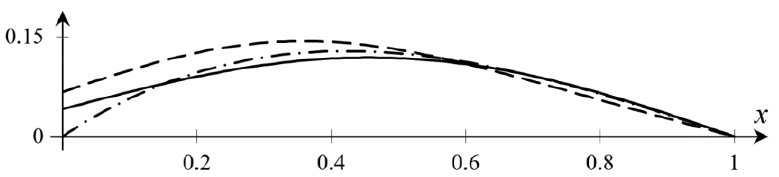
Figure 4. Graphs of 𝑄 1 (𝑥, 3) (solid line), 𝑄 2 (𝑥, 3) (dashed line) and 𝜑 1 (𝑥) (dash-dotted line). Graphical representations of the functions 𝑄 1 (𝑥, 6) and 𝑄 2 (𝑥, 6) and 𝑄˙ 1 (𝑥, 6) and 𝑄˙ (𝑥, 6) are shown in Figures 5 and 6, respectively.